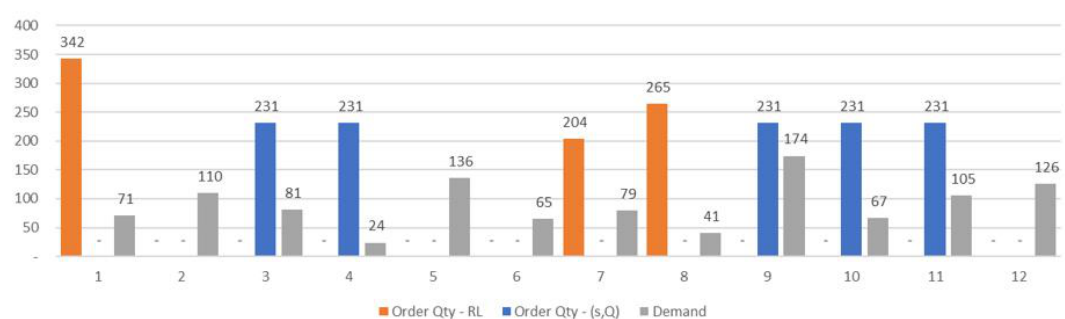
Fig. 5 Order Quantity vs Demand of Agent 1B - Scenario 2